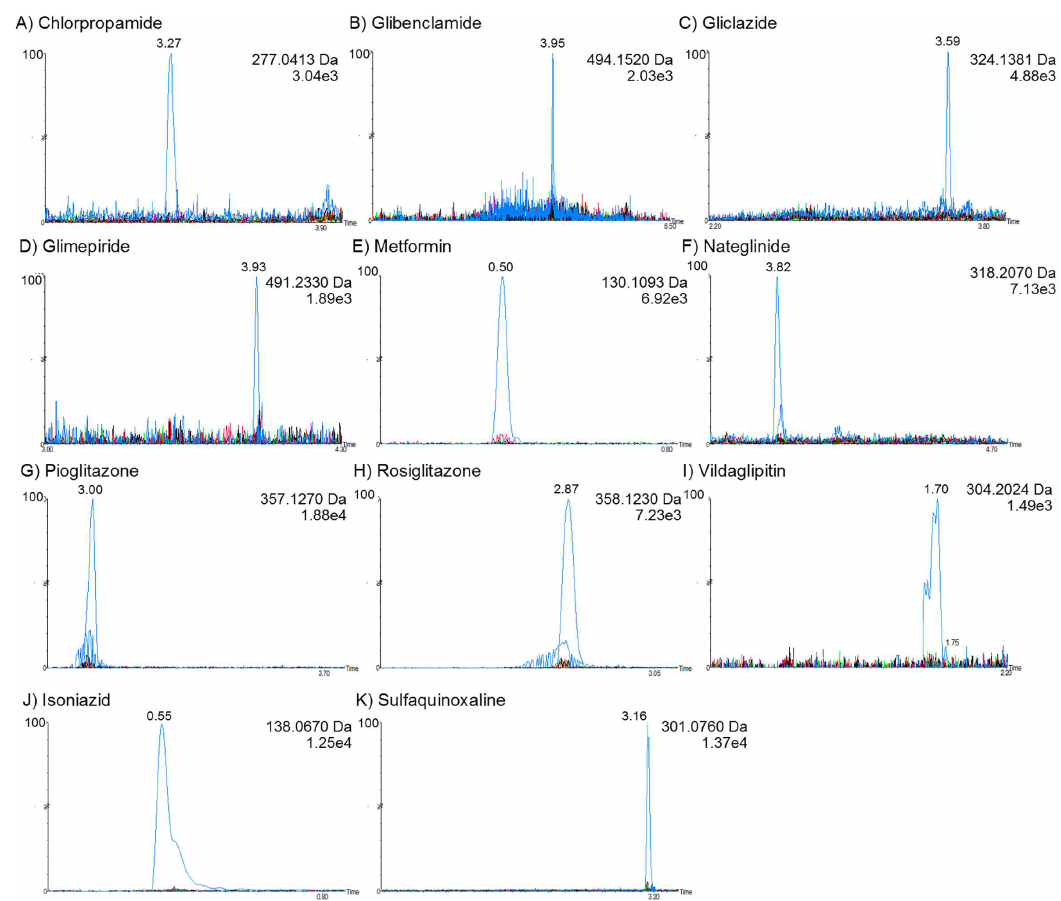
Fig 3. Selectivity study: Chromatograms of antidiabetic agents overlapping blank plasma chromatograms. (A) chlorpropamide; (B) glibenclamide; (C) gliclazide; (D) glimepiride; (E) metformin; (F) nateglinide; (G) pioglitazone; (H) rosiglitazone; (I) vildagliptin; (J) isoniazid(IS); and (K)